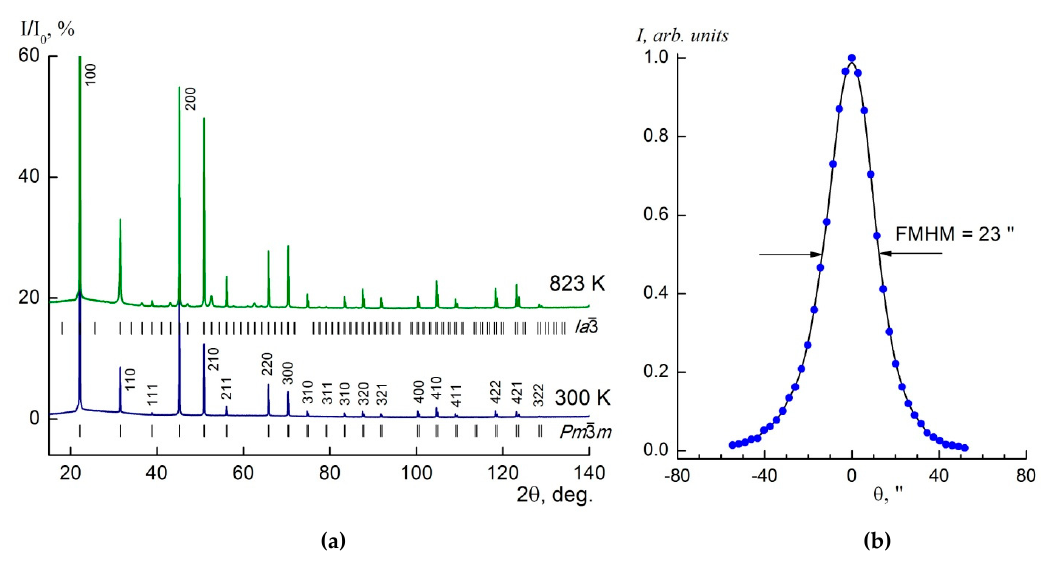
Figure 3. ( a ) XDR patterns of the as-grown and heat-treated at T = 823 K ScF3 crystals. The Bragg reflections positions for the Pm 3 m and Ia 3 space groups are indicated; ( b ) X-ray rocking curve of ScF 3 crystal 222 reflection.